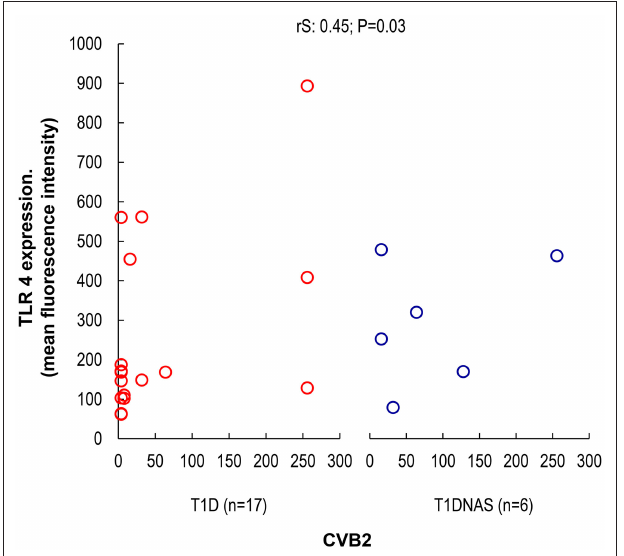
FIGURE 3 | Correlation between TLR4 expression in monocytes by mean fluorescence intensity (MFI) and the presence of neutralizing antibodies against CBV2 in type 1 diabetes patients (T1D) ( N = 17) and their non-affected siblings (T1DNAS) ( N = 6) rS: 0.45; P = 0.03.